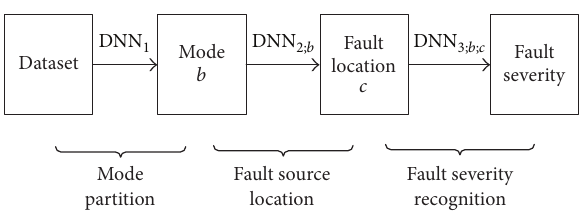
Figure 4: A hierarchical DNN framework of three